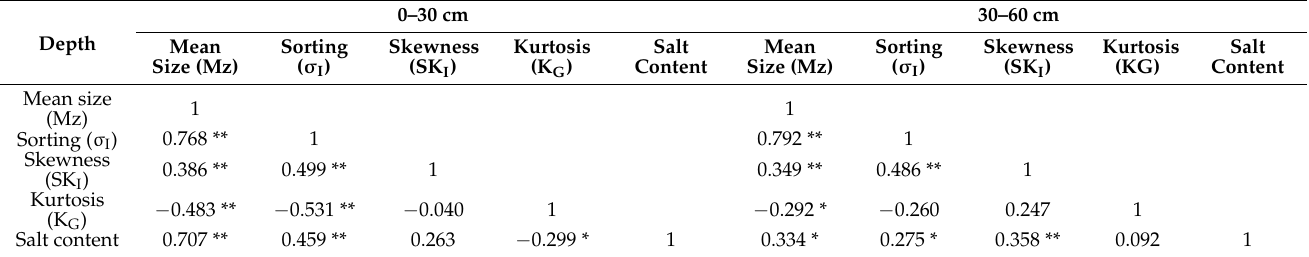
Table 3. Correlation analysis between grain size parameters and salt content of sediments from different landscapes.